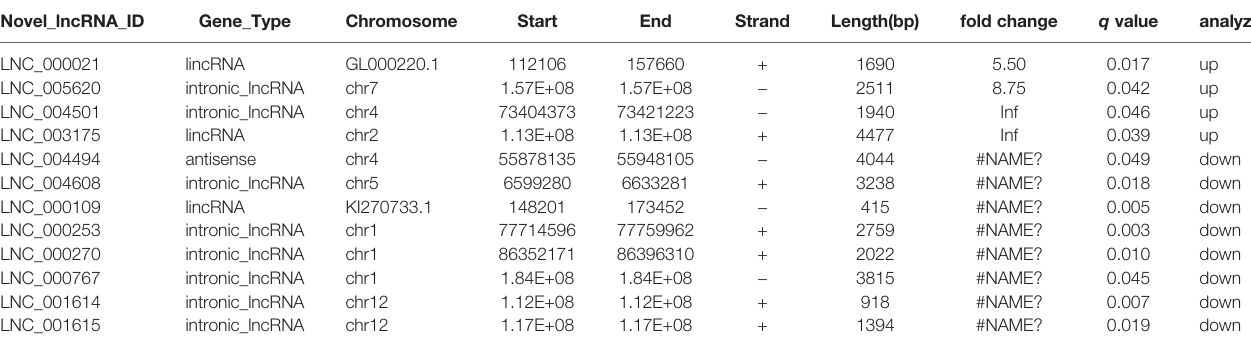
TABLE 1 | Differentially expressed lncRNAs of epirubicin-resistant and native MDA-MB-231 cells identi fi ed by